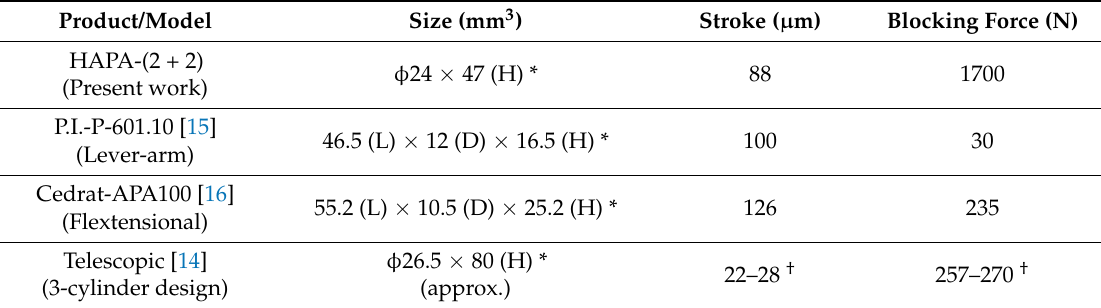
Table 2. Performance comparison of HAPA, lever-arm, flextensional, and telescopic actuators.